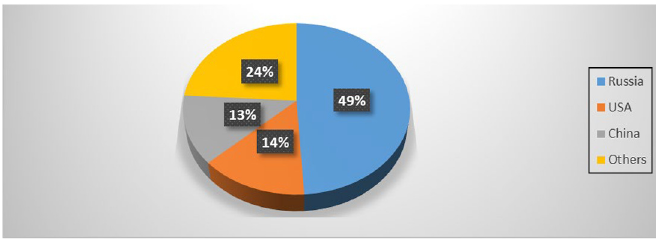
Figure 3. Arms exports to Africa by %